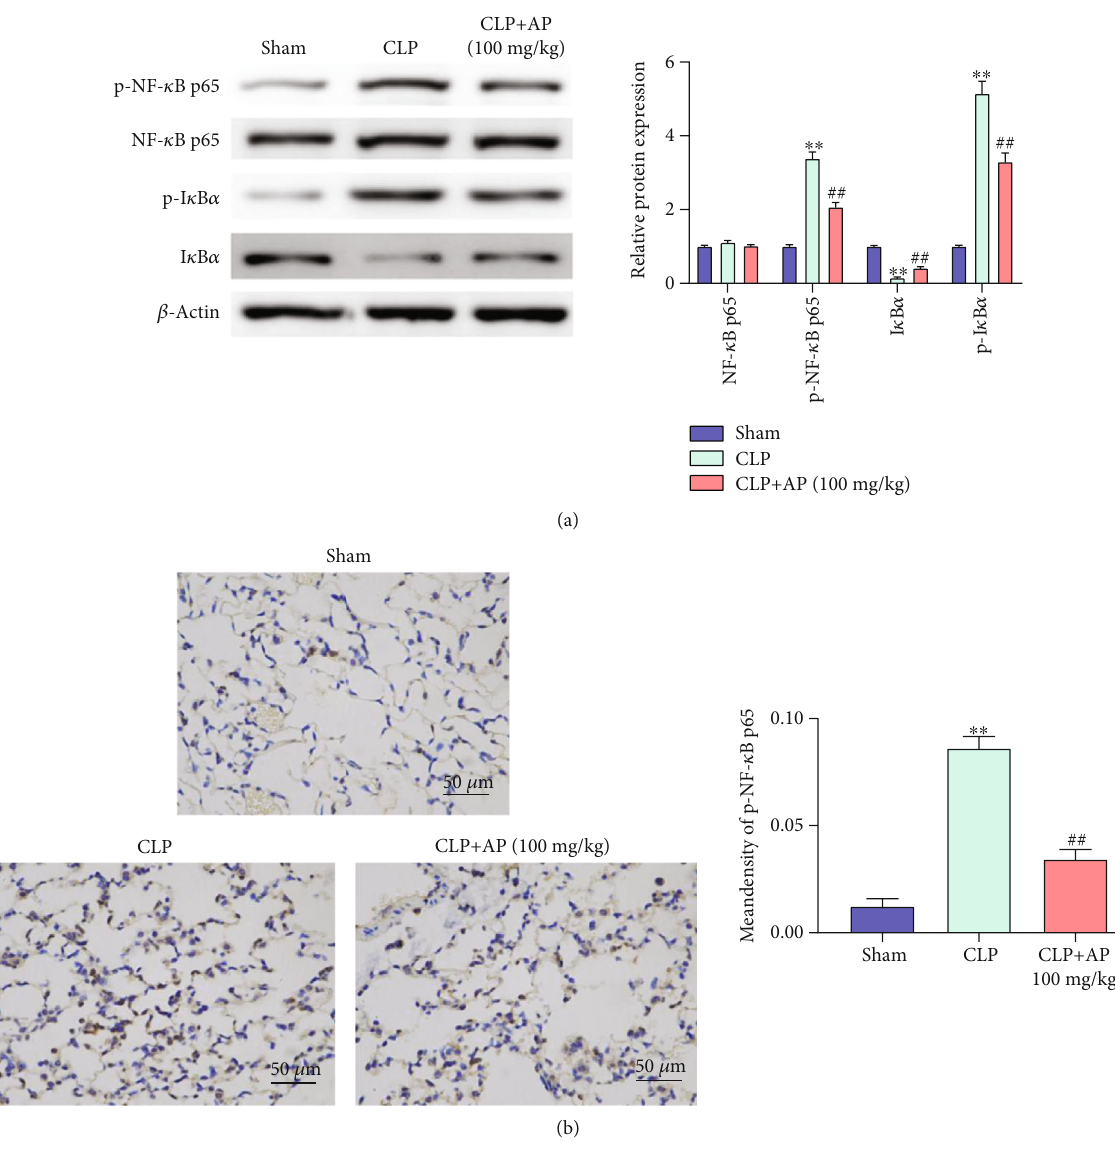
Figure 5: AP inhibited the activation of the NF- κ B pathway in sepsis-induced ALI mice. (a) The expressions of NF- κ B p65, p-NF- κ B p65, I κ B α , and p-I κ B α were measured by western blot. (b) The expression of p-NF- κ B p65 was detected by immunohistochemistry. ∗∗ P < 0 : 01 , vs. Sham group; ## P < 0 : 01 , vs. CLP